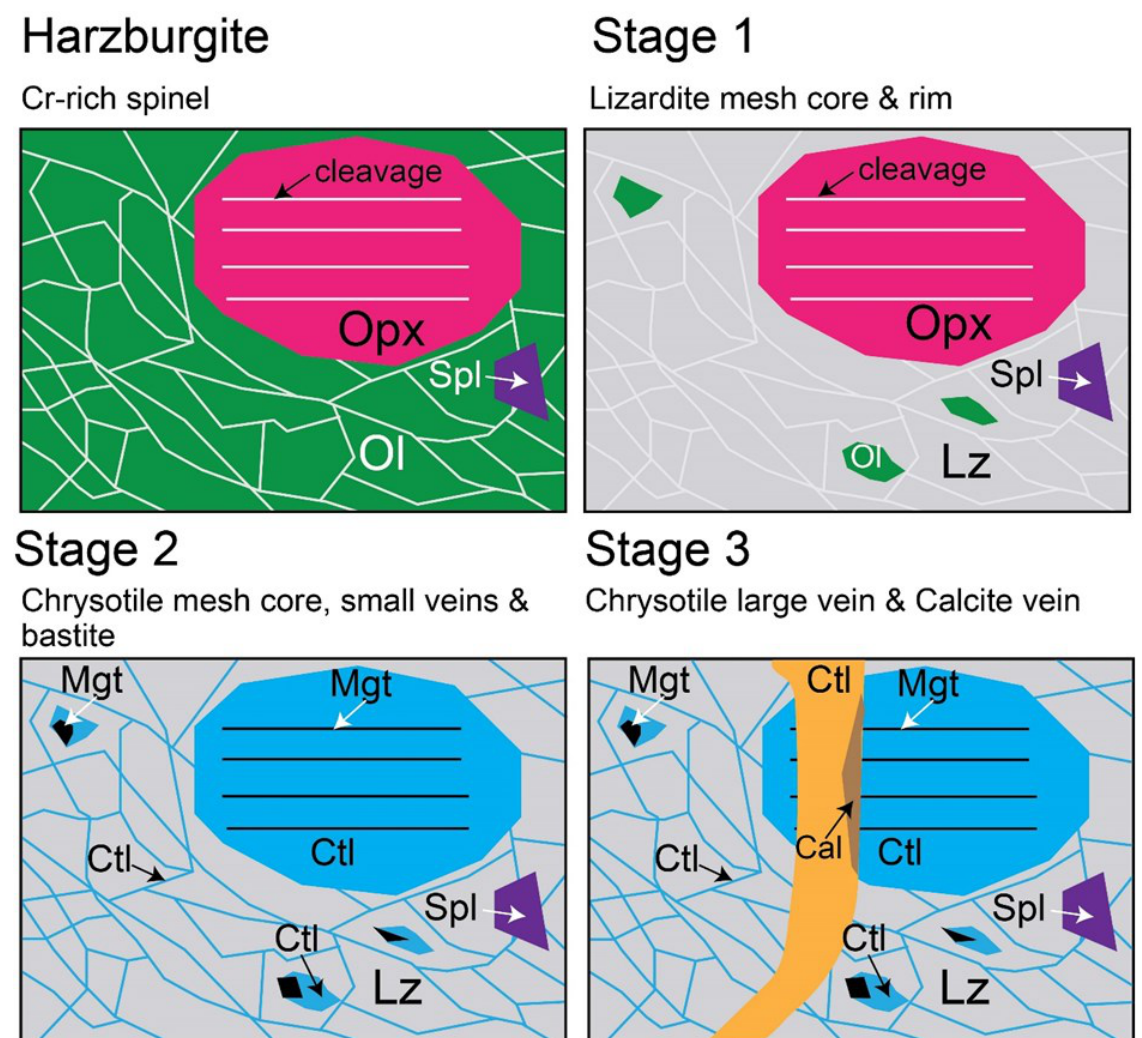
Fig. 6. Microtextural evolution of the three-stage serpentinization of harzburgite in the ultramafic rocks of the Manlay